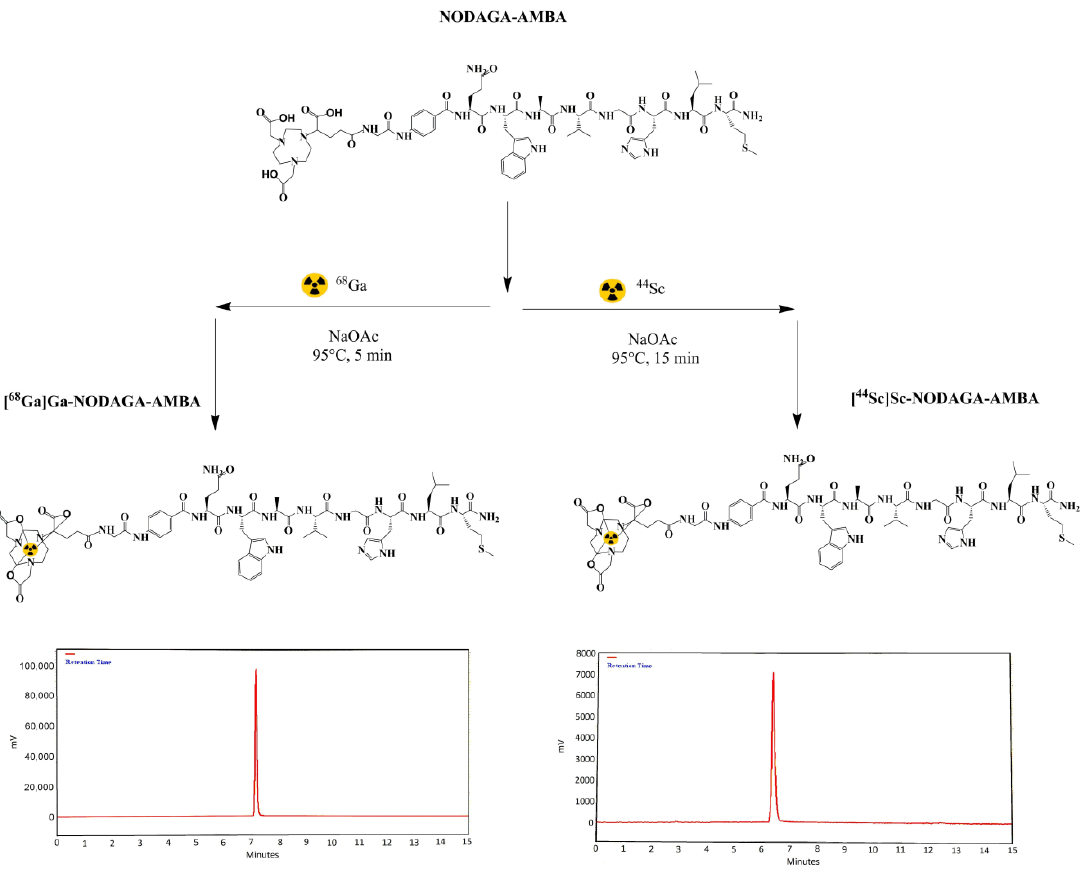
Gly-4-Abz-Gln-Trp-Ala-Val-Gly-His-Leu-Met-NH 2 (NODAGA-AMBA) precursor and radio-HPLC Figure 1. Schematic representation of 68 Ga and 44 Sc radiolabeling reactions of the NODAGA ‐ Gly ‐ 4 ‐ chromatogram of the [ 68 Ga]Ga-NODAGA-AMBA and [ 44 Abz ‐ Gln ‐ Trp ‐ Ala ‐ Val ‐ Gly ‐ His ‐ Leu ‐ Met ‐ NH 2 (NODAGA ‐ AMBA) precursor and radio ‐ HPLC chro ‐ matogram of the [ 68 Ga]Ga ‐ NODAGA ‐ AMBA and [ 44 Sc]Sc ‐ NODAGA ‐ AMBA.